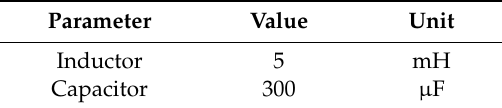
Table 2. LC filter